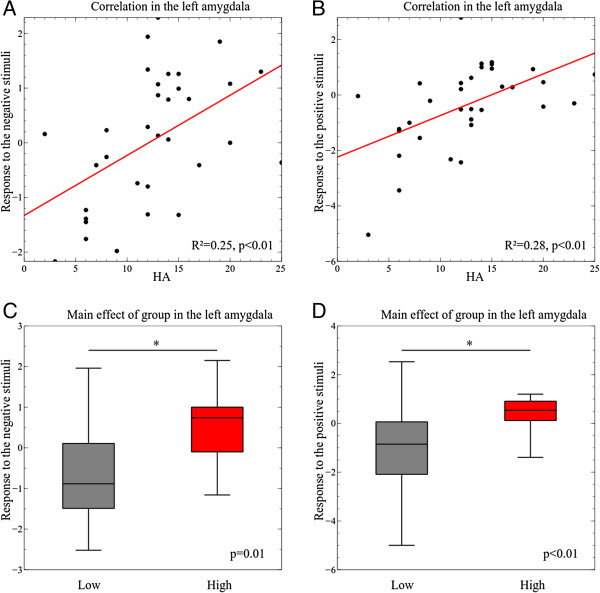
Correlation and box plots presenting the observed correlations and
main effect in the left amygdala. The plots show the
observed correlation between the left amygdala response to the
negative stimuli and HA (A) and between the left amygdala
response to the positive stimuli and HA (B). The box plots
exhibit the left amygdala response to the negative stimuli
(C) and the response to the positive stimuli (D)
in the low and high HA group. The whisker bars from the box plots
presents the minimal and maximal neural response measured. The
asterisks indicates significant group differences.